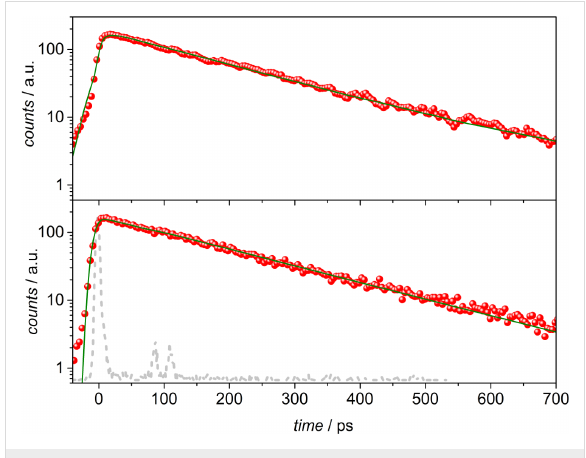
Figure 2: Fluorescence decays (dots) in the 500–520 nm spectral region (emission range of the Z -isomer) for 1 in toluene upon excita- tion of the E -form at 350 nm (top; induced Z -emission), and upon exci- tation of the Z -form at 400 nm (bottom). The mono-exponential fittings are reported as full lines. The excitation profile is shown in dashed light